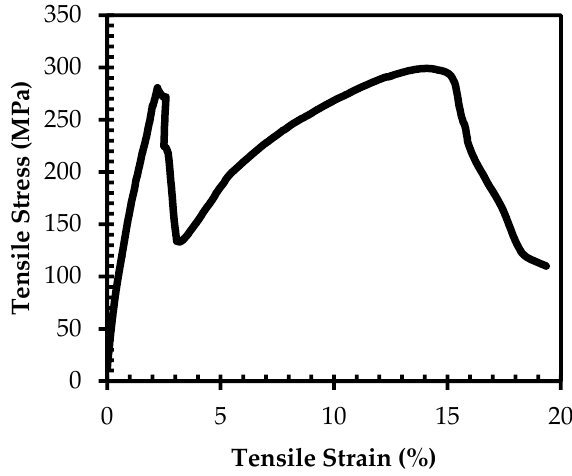
Figure 6. Example of dual-peak stress–strain curve obtained for CF-UHMWPE-CF / poly(3BOP-daC12) sandwich composite. Initial peak caused by failure of the carbon fiber skin layers followed by failure of the UHMWPE core layer.